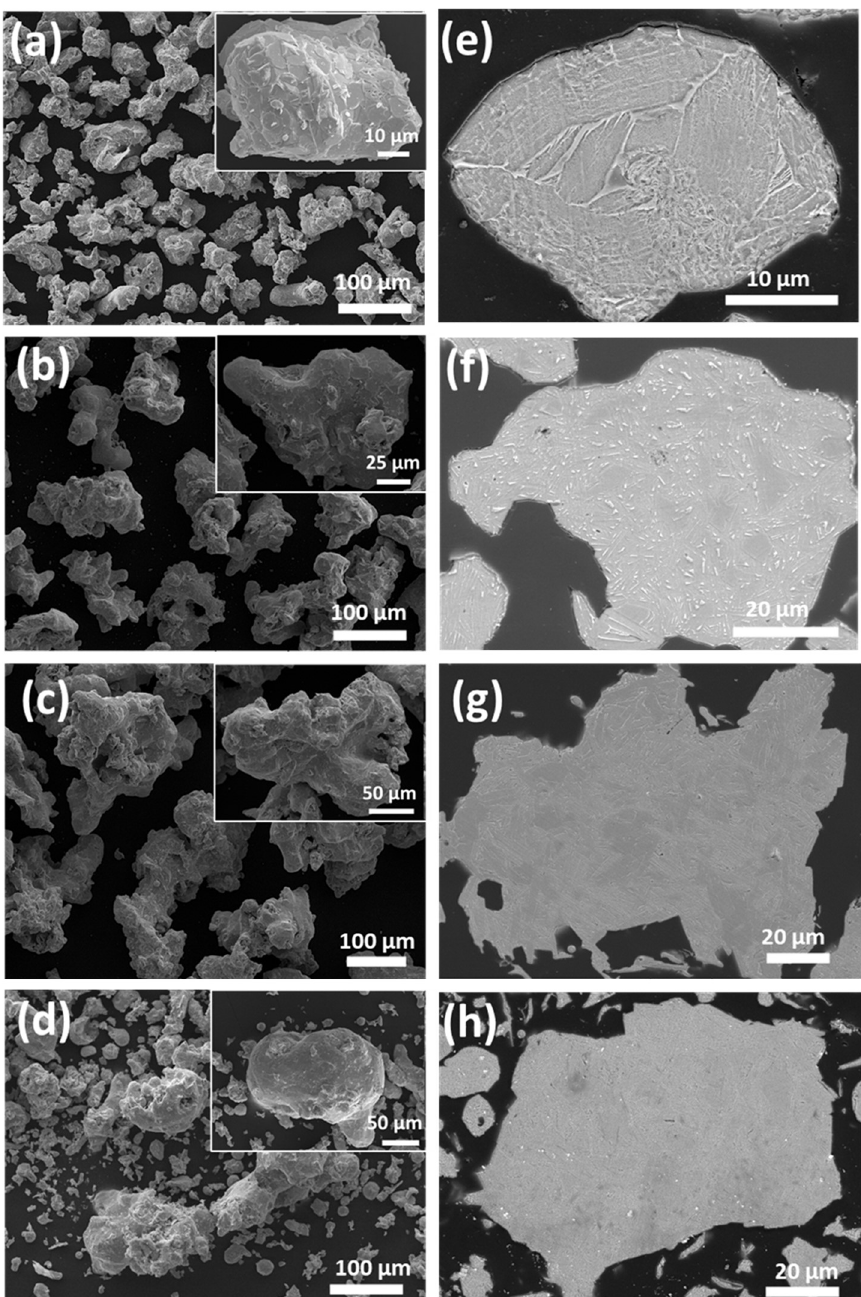
Figure 1. SEM powder morphology of ( a ) 32–75 µ m, ( b ) 75–125 µ m, ( c ) 125–200 µ m, and ( d ) <200 µ m size powders. The inset images are highly magnified. SEM powder cross-sectional images of ( e ) 32–75 µ m, ( f ) 75–125 µ m, ( g ) 125–200 µ m, and ( h ) <200 µ m. The insets show their